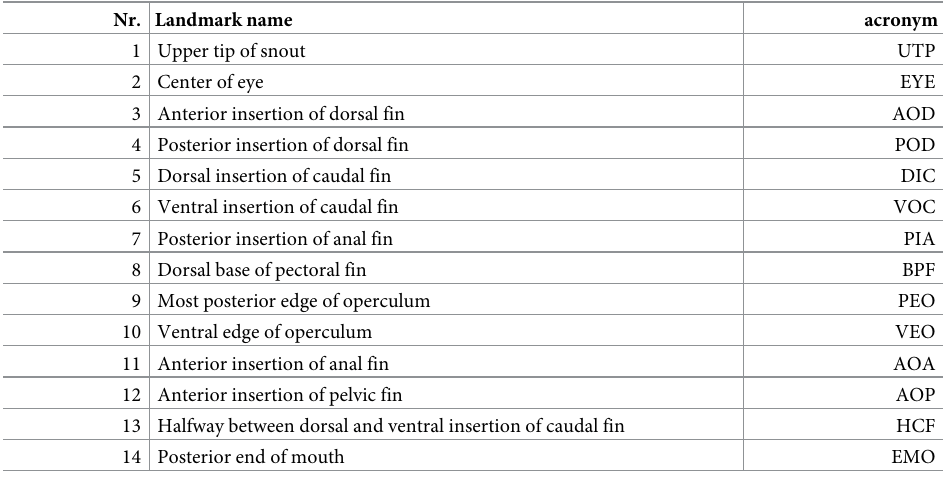
Table 2. Characterization of the 14 landmark positions in Fig